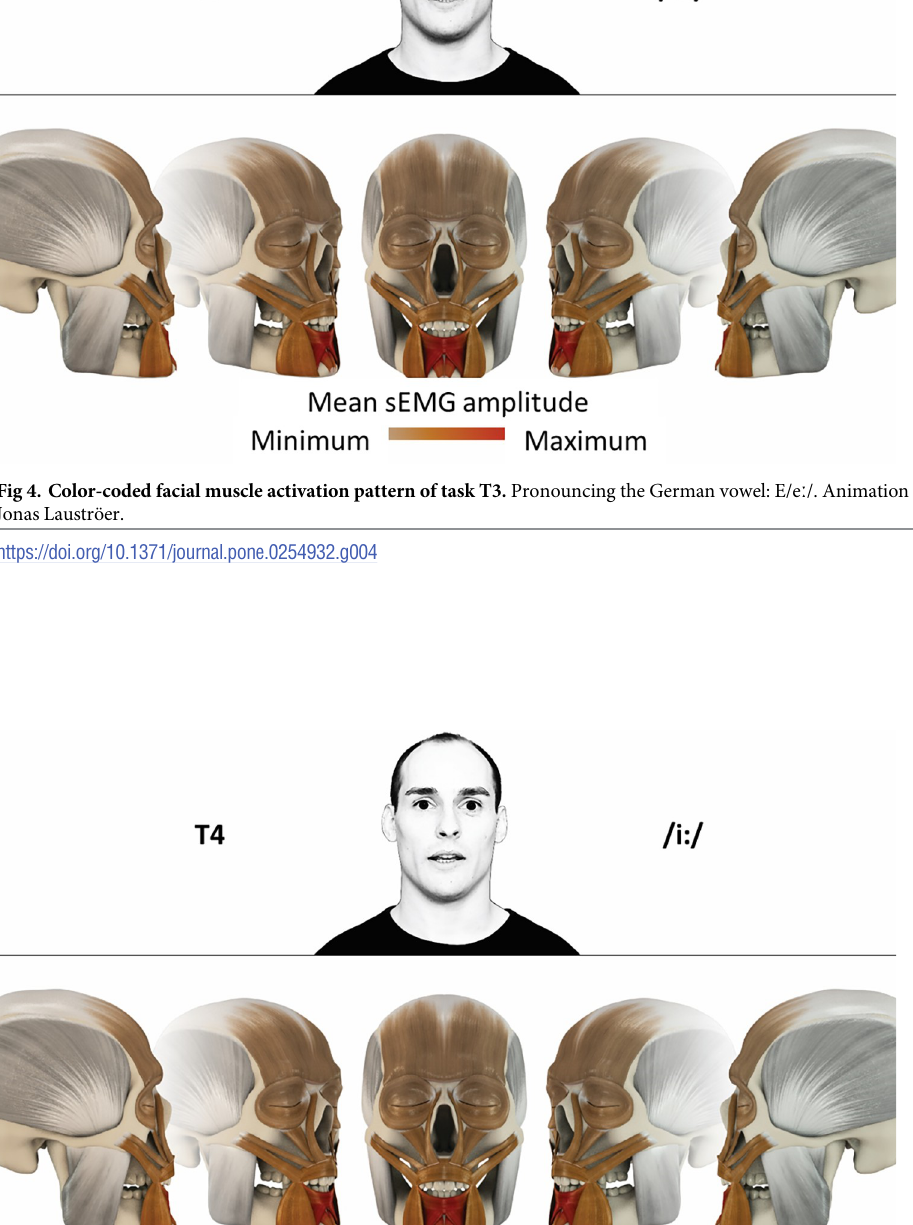
PLOS ONE | https://doi.org/10.1371/journal.pone.0254932 July 19,